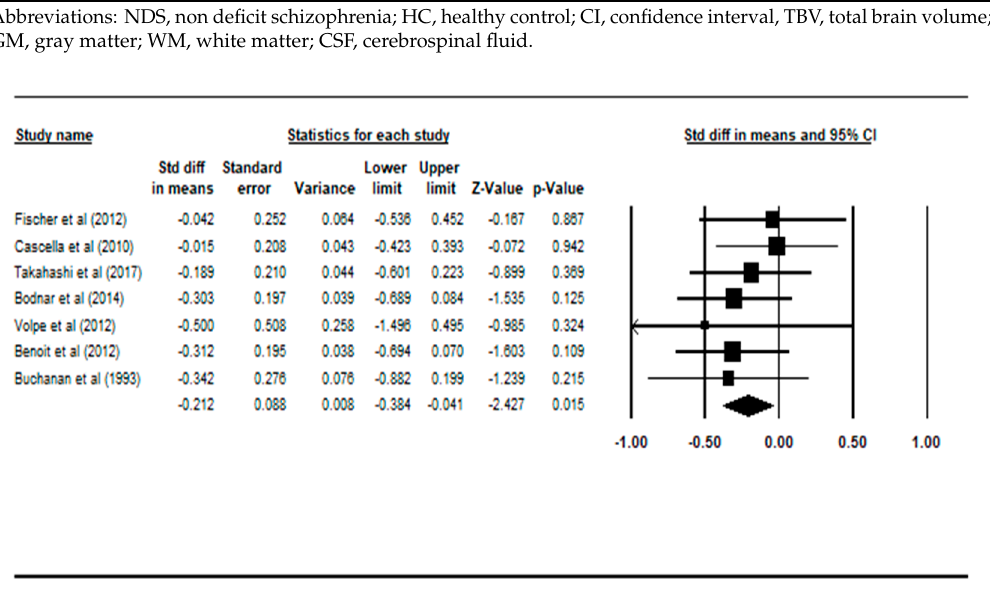
Figure 4. Forest plot: NDS vs. HC, total brain volume. Abbreviations: Std diff, standard difference; CI, confidence interval.